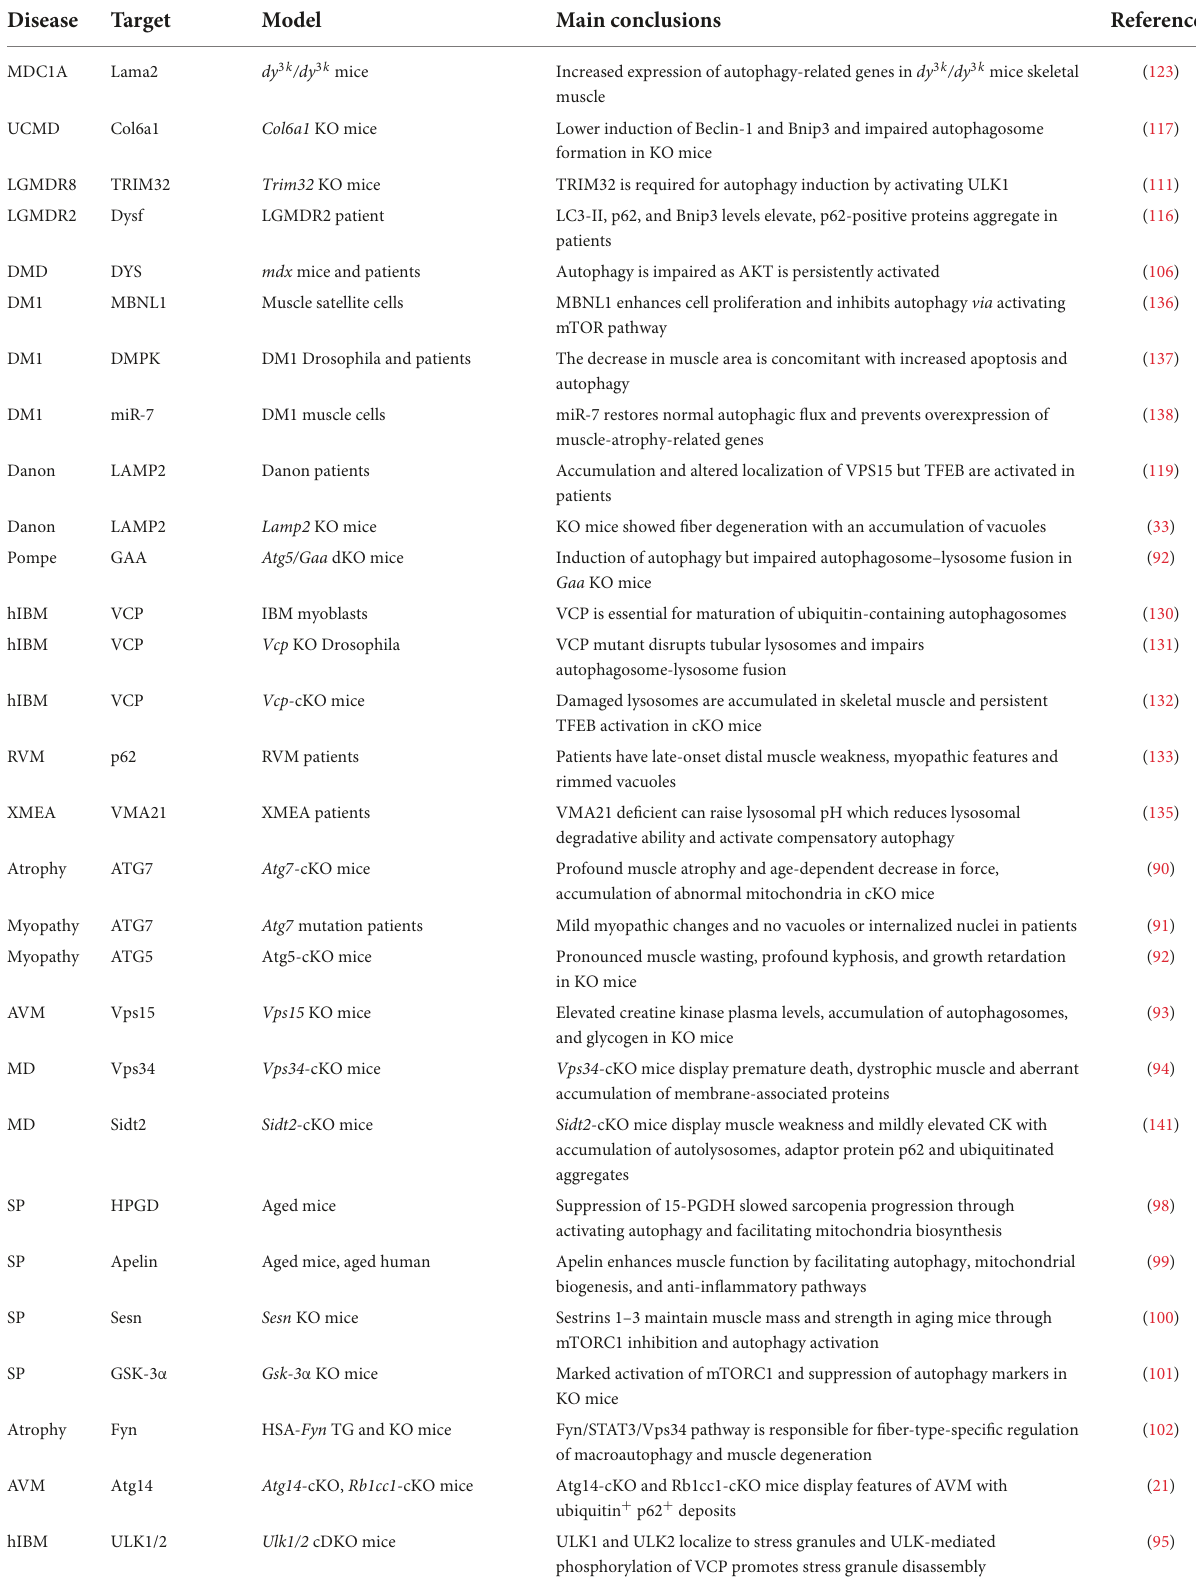
TABLE 3 Autophagy in skeletal muscle